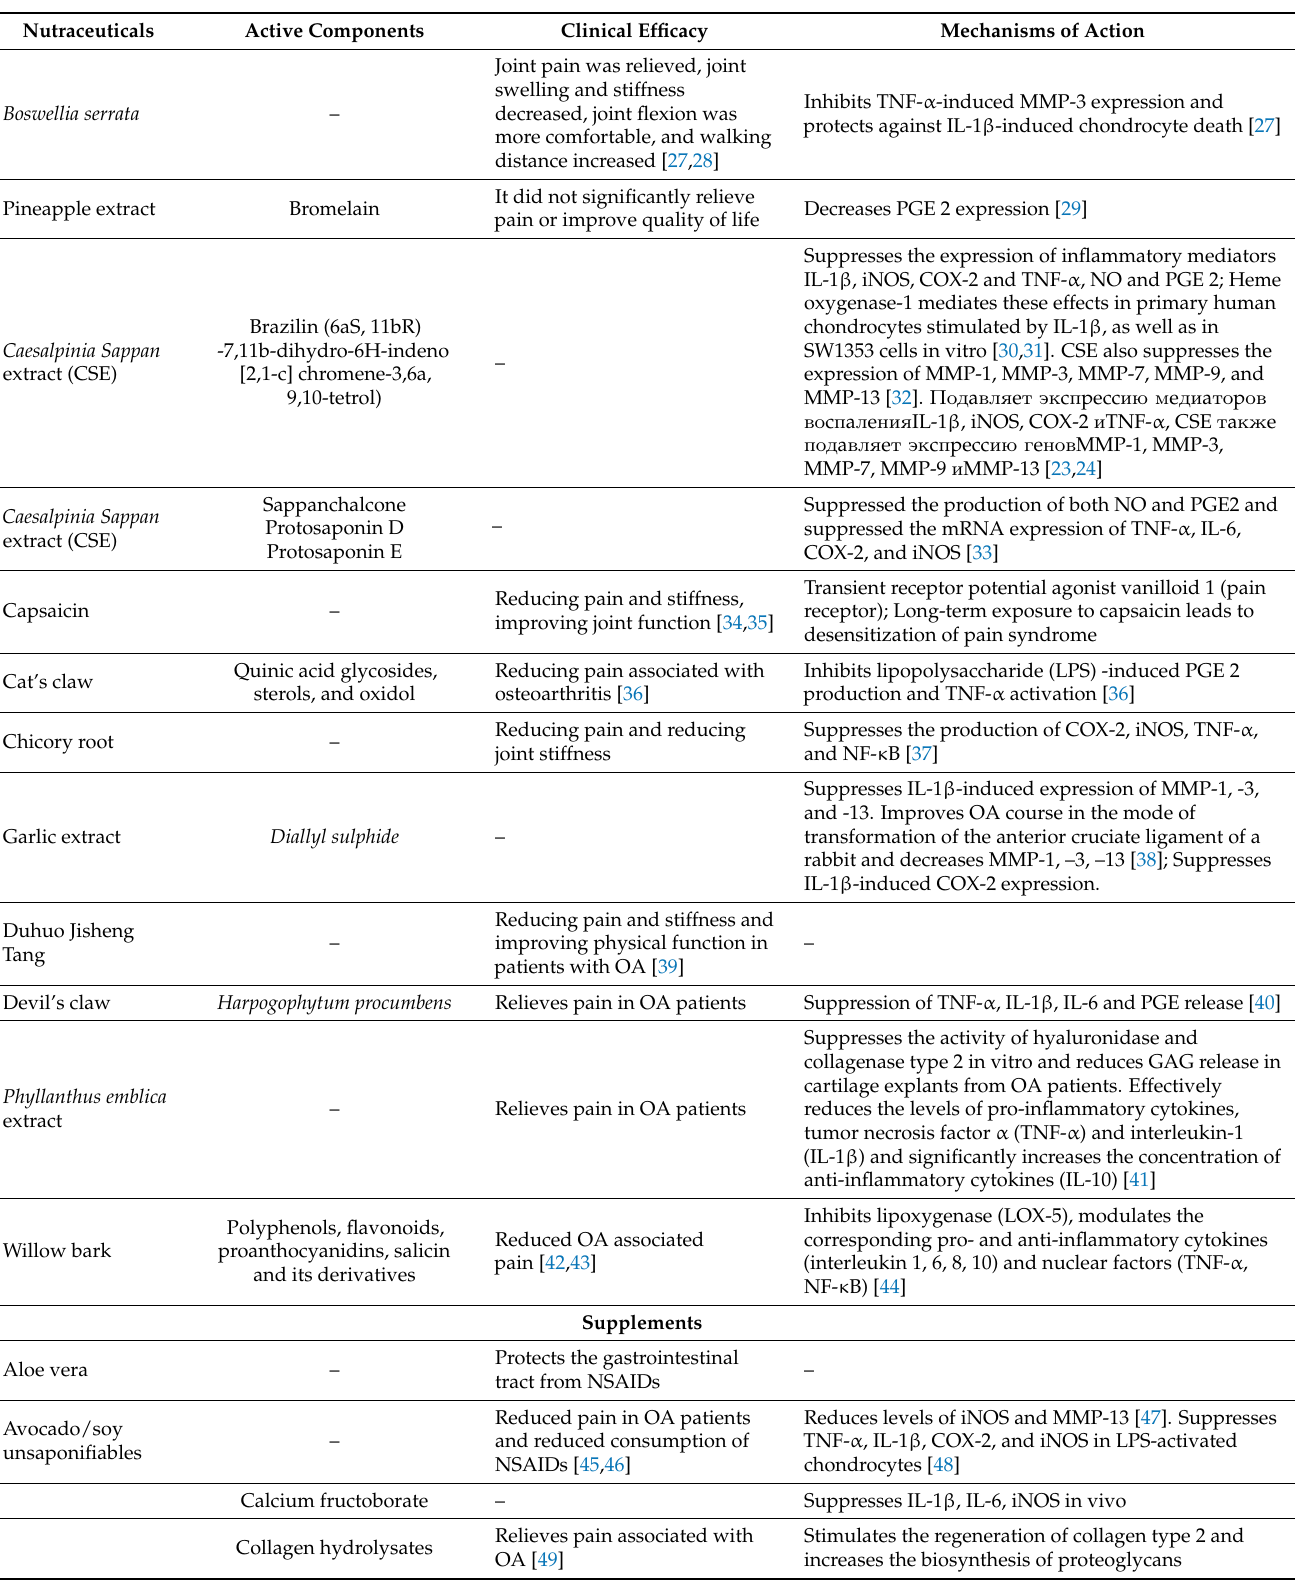
Table 1. Overview of the clinical efficacy and mechanism of action of nutraceuticals